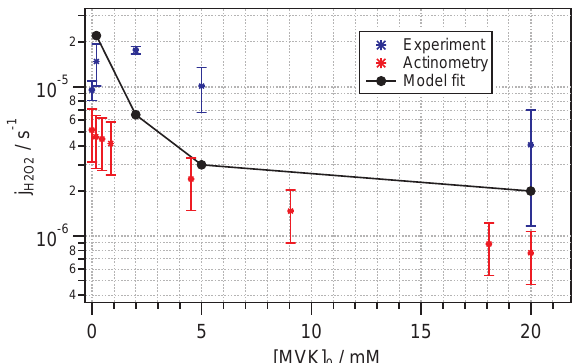
Figure 3. Experimentally determined photolysis rates for H 2 O 2 (blue), and calculated data based on actinometry (red) using Eqs. (1) and (3), as a function of MVK initial concentration. Photolysis rate constants, fitted by the model in order to match MVK decay pro- files for experiments with different initial MVK concentrations, are shown in